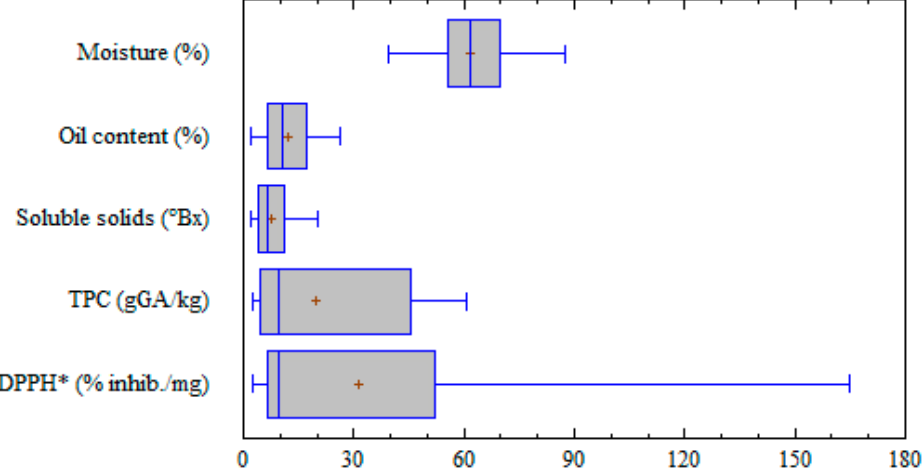
Figure 1. Box and whisker plots showing the descriptive statistics for the chemical variables tested on olive drupes. TPC: total phenol content; GA: gallic acid equivalent; DPPH • : radical 2,2 diphenyl-1-picrylhydrazyl; inhib.: inhibition.